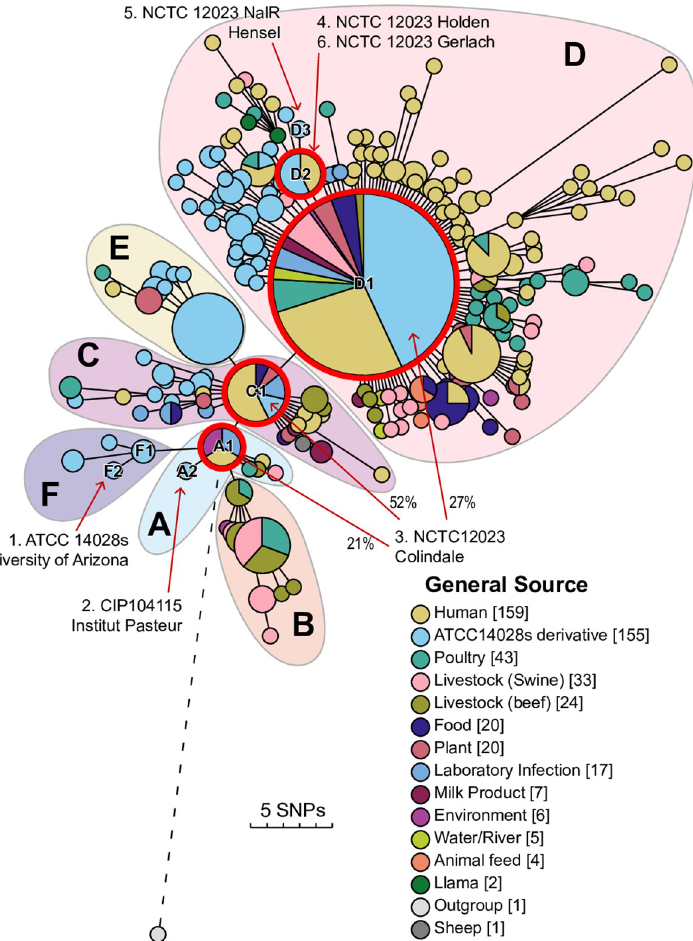
Fig 4. Maximum likelihood (RaXML-NG [67])phylogenetic tree of 462 non-repetitive SNPs in 496 genomes of strains in HC20_373 plus one outgroup genome (strain SAP17-7699;NCBI Accession GCF_005885875; EnteroBase barcode SAL_AB1180AA) from the related HC20 cluster, HC20_147. The tree is presented with GrapeTree [57]. Indistinguishable genomes were collapsed into pie-chart nodes, the areas of which are proportional to the number of genomes, and whose color-coded sectors indicate their General Source (Key Legend). The phylogenetic root of HC20_373 is indicated by the branch connecting node A1 with an outgroup genome from HC20_147 (EnteroBase strain barcode SAL_AB1180AA). Other branches were rotated manually without distorting their topologies in order to cluster tips by General Source. A visual examination of the tree indicates a temporal progression from the root (A1) to the current versions of individual laboratory strains (S2Table):1. ATCC14028s University of Arizona (U.S.A.; node F2; 1960), 2. CIP104115Institut Pasteur (Paris; A2; 1994), 3. NCTC 12023 Colindale (London; A1; 1987) and 4. NCTC 12023 Holden (London; D2; 1995), 5. NCTC 12023 NalR Hensel (Erlangen; D3; 1996), 6. NCTC 12023 Gerlach (Wernigerode; D2; 2003). The percentages of each of three heterozygous variant SNPs in the completed genome of NCTC 12023 (S2Table) are indicated on lines from nodes A1, C1 and D1 to 3. NCTC12023 Colindale. This temporal progression is also in accord with an arbitrary partitioning of the tree into six sectors, A-F, consisting of apparent radial expansions of variants from central nodes (A1, C1, D1, F1, etc.). Partition D contains ATCC14028s variants from various global sources. E includes laboratory-derived mutants of ATCC14028s[68]plus their descendantnodes. F includes an early isolate of ATCC14028s (node F2) sequenced by Jarvik et al .[1].D, E and F are separated by internal partitions A and C. Partition A was the parent of partition B, which consists of strains from natural sources. Interactive plots of the data including additional metadata can be found at